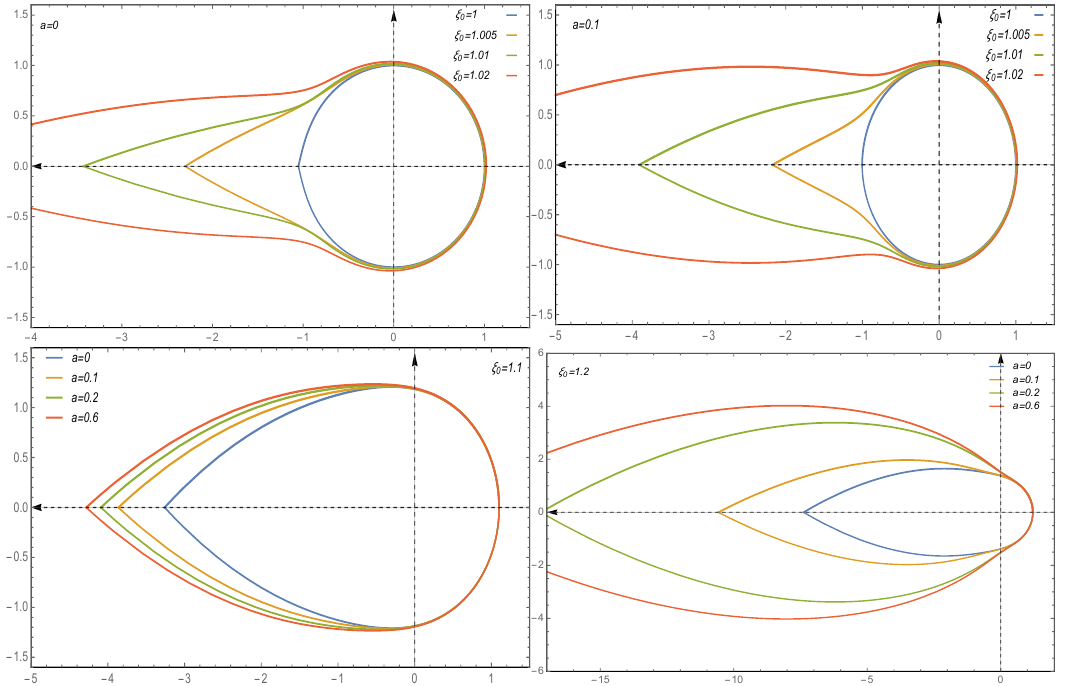
Figure 7 . The configuration of the D5-brane as baryon vertex in { ξ, η } plane. Note ξ and η is the radius and polar angle. In the upper figures, we fix a = 0 , 0 . 1 respectively then adjust ξ 0 ; in the lower figures, we fix ξ 0 = 1 . 1 , 1 . 2 then adjust a . The numerical calculation always illustrates wrapped shape of the baryon